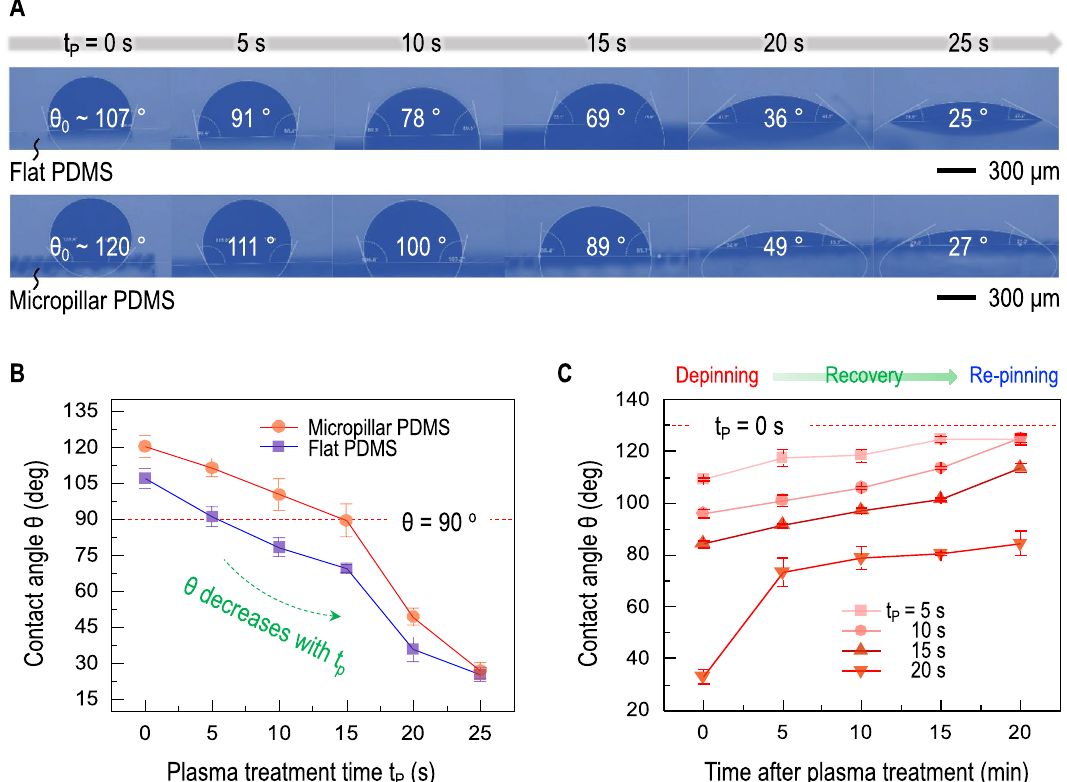
Figure 3. Wettability control with plasma treatment. ( A ) Initial contact angles decrease with increasing plasma treatment time ( t p ) for both flat and micropillar PDMS (Acquired with Drop Shape Analyzer and Advance ◦ ◦ Software, Krüss Science). ( B ) Initial hydrophobicity ( θ > 90 ) turns into hydrophilicity ( θ < 90 ) at t p ∼ 5 s for flat PDMS and at t p ∼ 15 s for PDMS micropillars. ( C ) Hydrophilicity transition by plasma treatment is temporary, and recovery to hydrophobicity is shown in contact angle changes with time after plasma treatment. Early hydrophobicity is favorable for depinning, contributing to flattening the upper bump, and late recovery is favorable for re-pinning, contributing to the final deposit shape by surface area